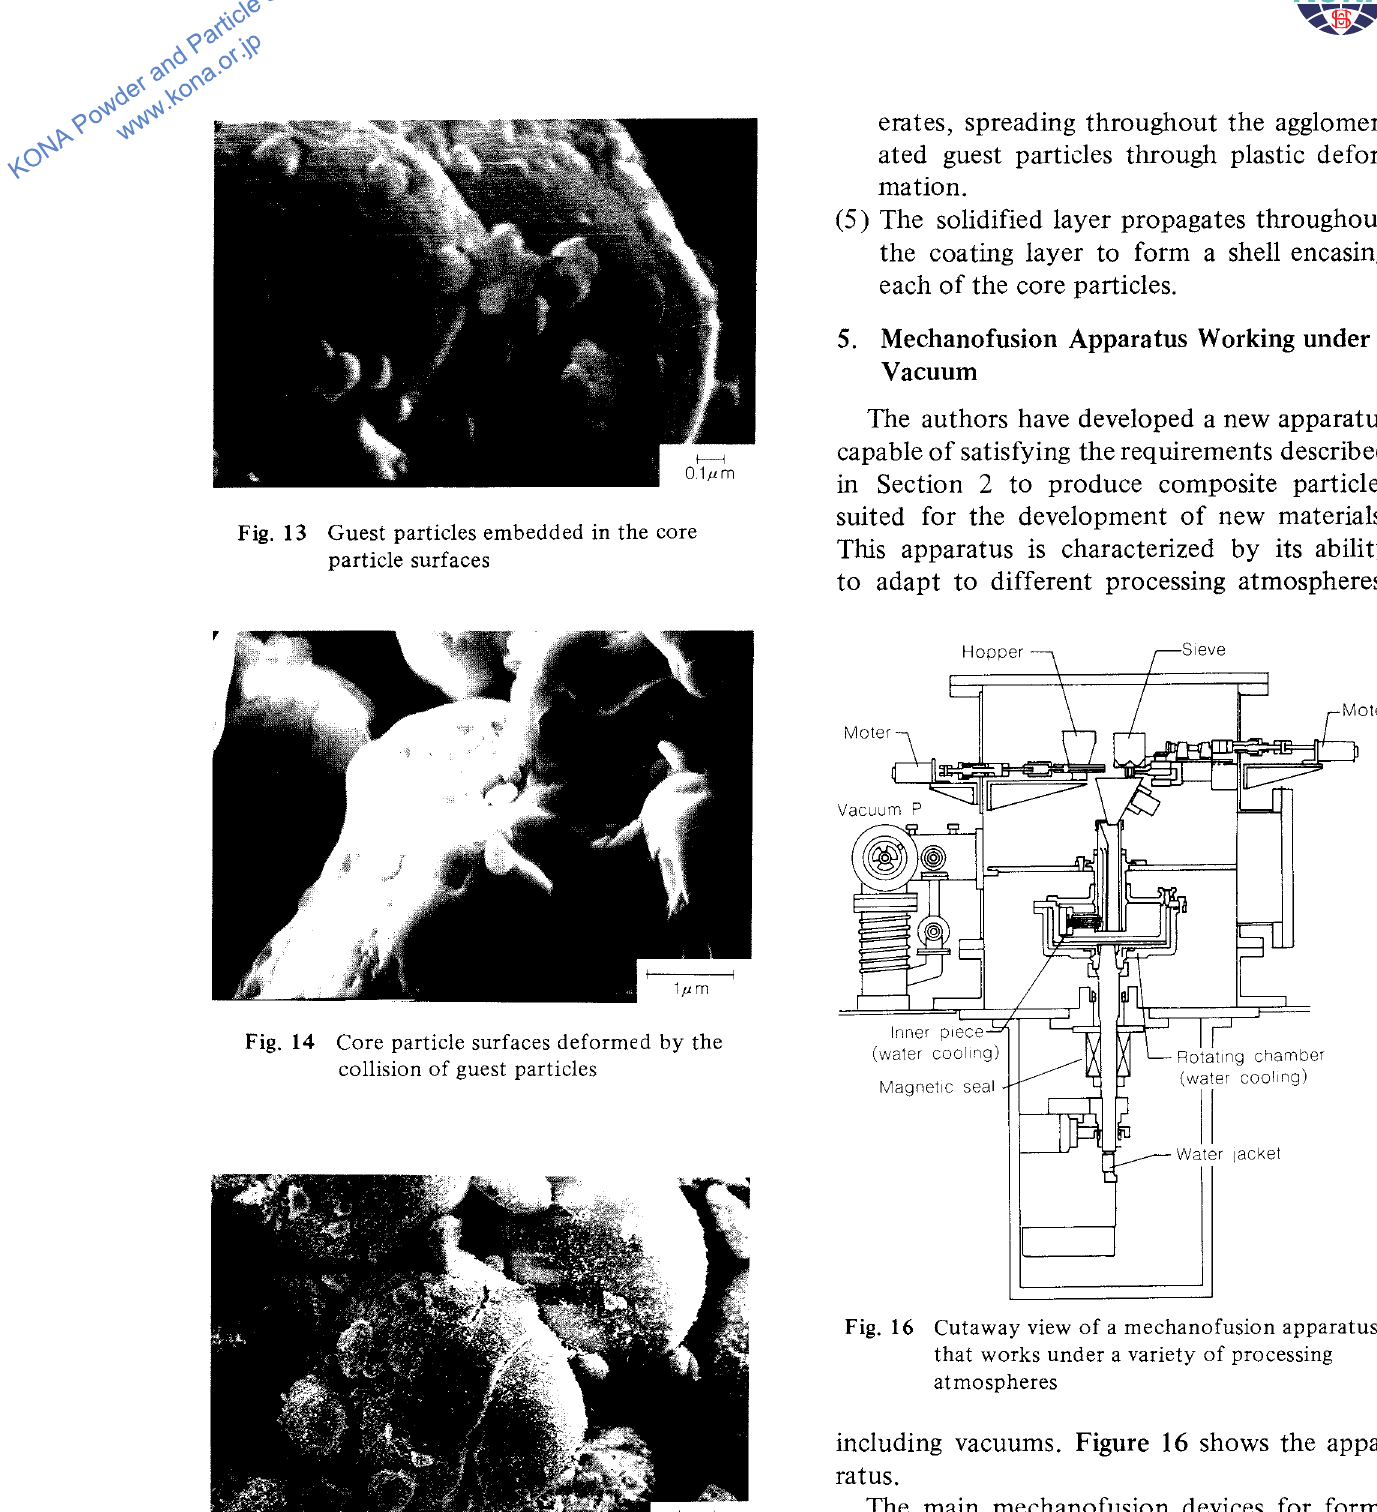
Fig. 16 Cutaway view of a mechanofusion apparatus that works under a variety of processing